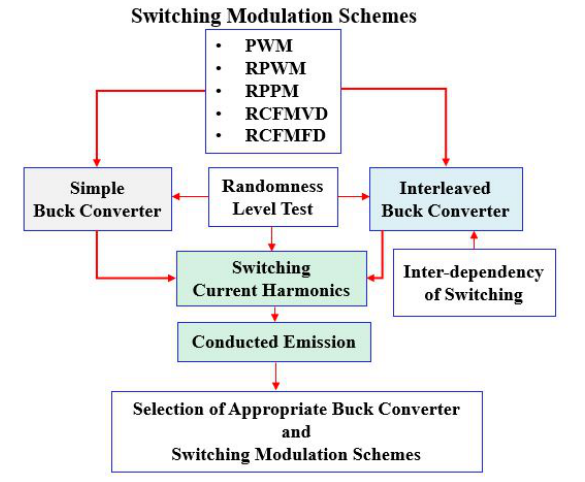
Figure 1. Analysis strategy for the selection of an appropriate buck converter and switching modula- tion schemes.